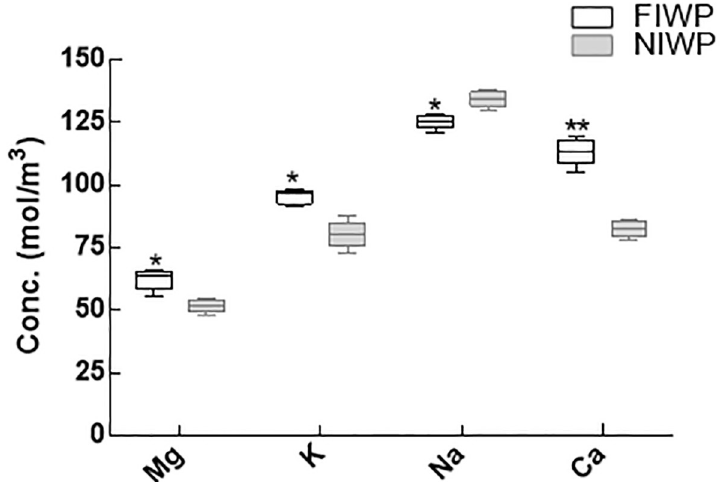
Fig 8. Nutrient uptake of CGF-1 inoculated and non-inoculated wheat plants. CGF-1 inoculated and non- inoculated wheat plants were analysed for the nutrient uptake from the heavy metal contaminated soil; FIWP = fungal inoculated wheat plant; NIWP = non-inoculated wheat plant; Mg = magnesium; K = potassium; Na = sodium; Ca = calcium. The experiment was carried out in triplicate, each replicate comprised of 10 pots and each pot contained 6 seedlings (total = 6 × 10 × 3 = 180 seedlings per treatment). Means of fungal inoculated wheat plants (FIWP) were compared with non-inoculated wheat plants (NIWP) by using ttest; ‘ �� ’ represents significant difference at P = 0.005; ‘ � ’ represents significant difference at P =